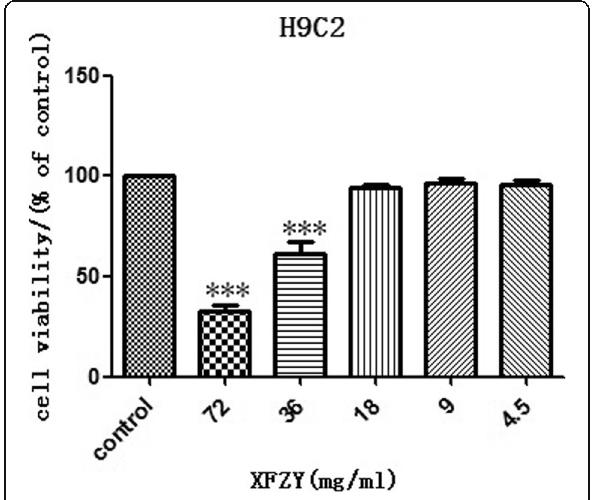
Fig. 2 Effects of XFZY on cardiomyocyte viability. Myocardial H9C2 cells were subjected to normoxia for 24 h and then incubated with MTT for 4 h at 37 °C. The results were expressed as mean ± SD. ***p < 0.001 vs Control